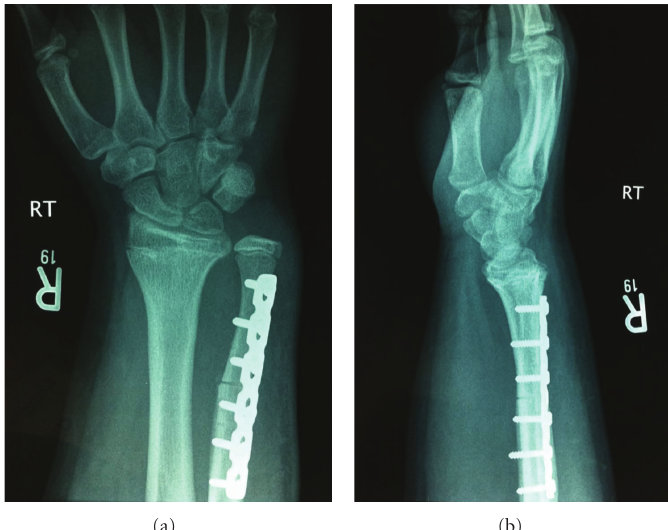
Figure 3: Postoperative anteroposterior and lateral radiographs demonstrating satisfactory ulnar shortening and fixation of the osteotomy